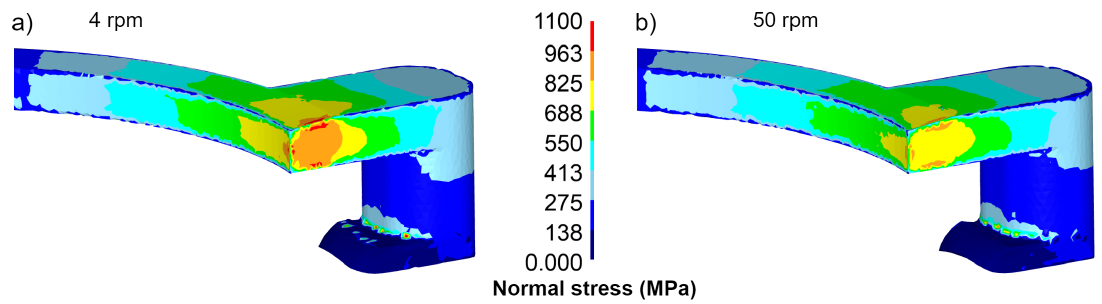
Figure 12. Normal pressure in the extrusion grip zone. ( a ) rotational speed 4 RPM; ( b ) rotational speed 50